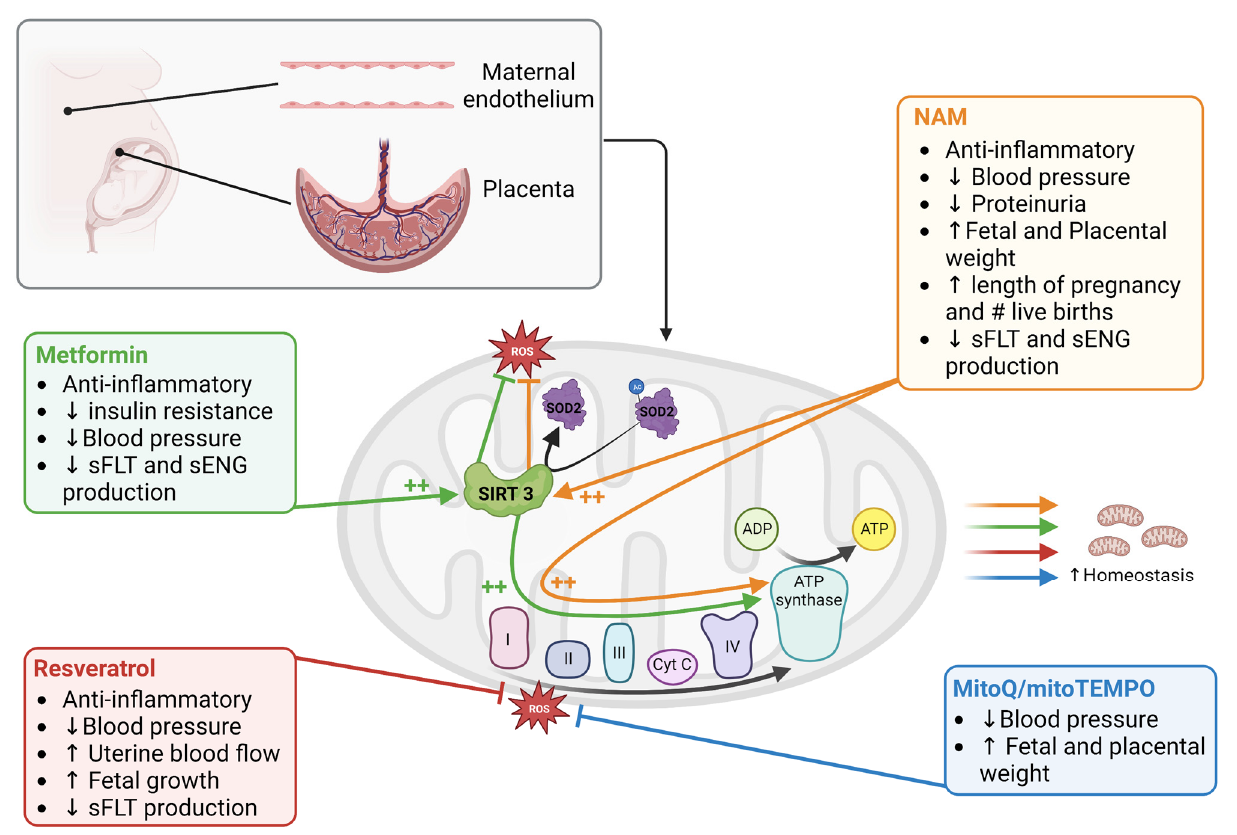
Figure 2. Mitochondria targeting treatments in preeclampsia. Among the drugs and nutraceuticals tested in PE studies, the most promising ones that target mitochondria are metformin, resveratrol, nicotinamide (NAM), and mitoQ/mitoTEMPO. Metformin, resveratrol, and NAM function on multiple pathways that improve mitochondrial biogenesis, function, quality control (by mitophagy), and reduce ROS; thereby establishing mitochondrial homeostasis under pathological conditions. MitoQ/mitoTEMPO act by reducing mitochondrial ROS which eventually improve mitochondrial homeostasis. The symbol ++ indicates increased activation, # indicates number, ↑ indicates increase and ↓ indicates decrease. Figure was created with Biorender.com, accessed on 13 February 2023.